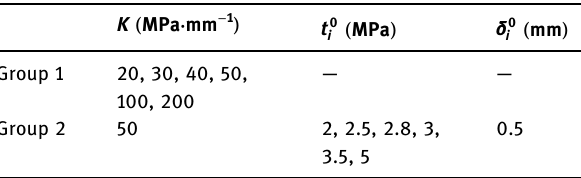
Table 3: Ranges of values of cohesive surface model parameters